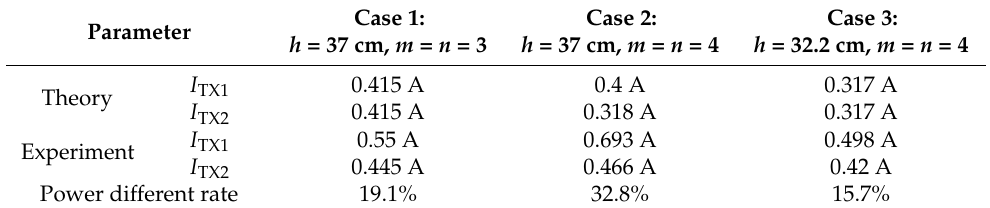
Table 2. Comparison of theoretical and experimental values.